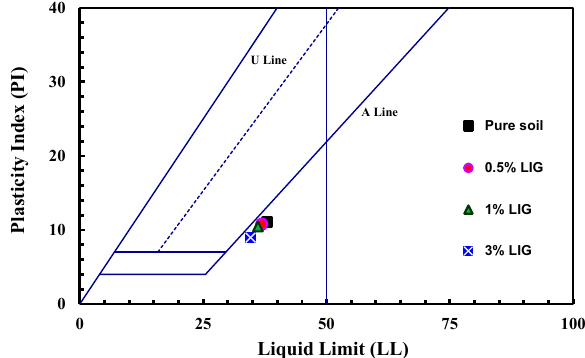
Figure 2. Plasticity chart for the untreated and LIG-treated soil.